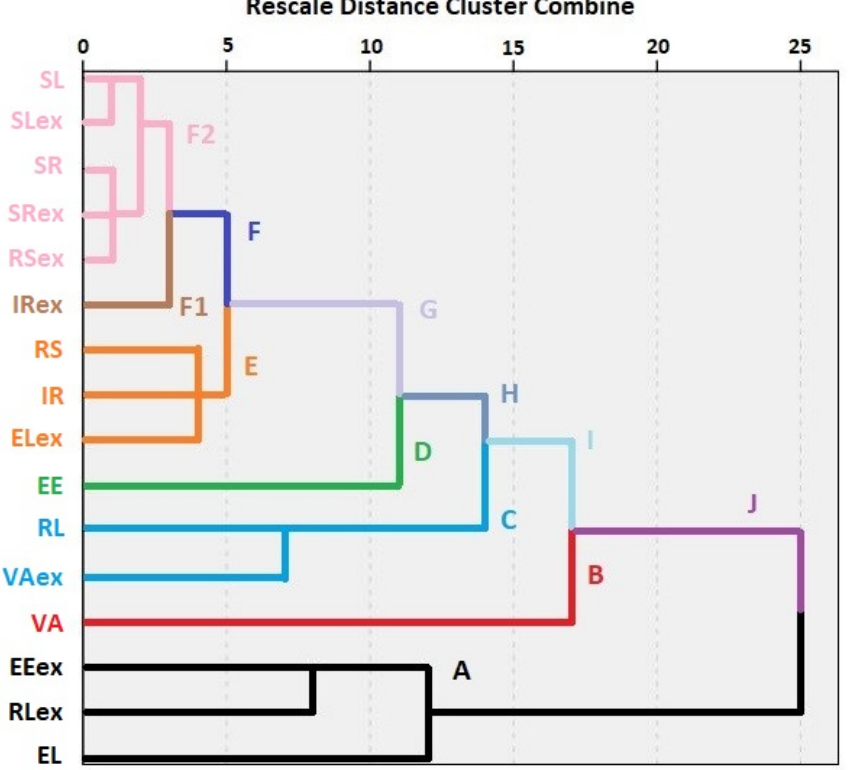
Figure 8. Dendrogram of polymer against the distance cluster combine index showing results of the Hierarchical Cluster Analysis